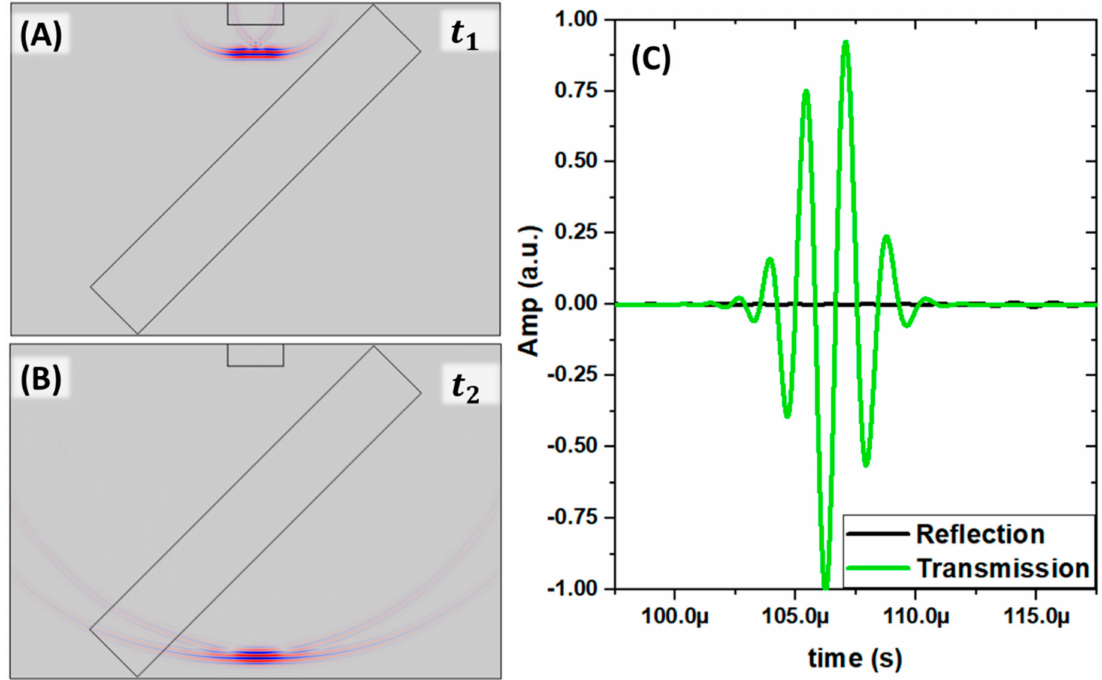
Figure 5. ( A ) Time-domain simulation of sound pressure field showing the incident pulse at 32 ◦ C ( B ) Separated pulses at 32 ◦ C and t 2 . ( C ) Measured acoustic reflection and transmission signals from ( A , B